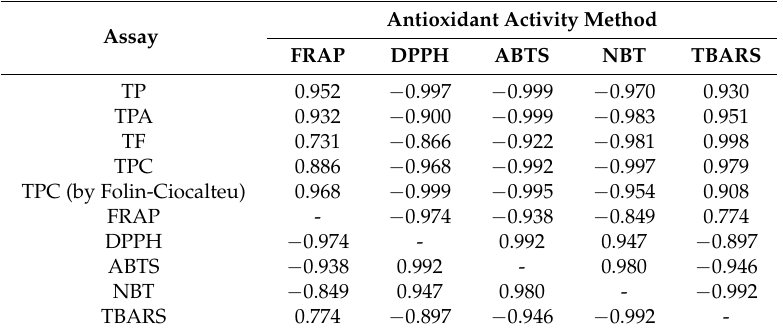
Table 3. Correlation coefficients ( r ) between antioxidant activity values and phenolic contents. Antioxidant Activity Method Assay FRAP DPPH ABTS NBT TBARS TP 0.952 − 0.997 − 0.999 − 0.970 0.930 TPA 0.932 − 0.900 − 0.999 − 0.983 0.951 TF 0.731 − 0.866 − 0.922 − 0.981 0.998 TPC 0.886 − 0.968 − 0.992 − 0.997 0.979 TPC (by Folin-Ciocalteu) 0.968 − 0.999 0.908 FRAP - − 0.974 − 0.938 − 0.849 0.774 DPPH − 0.974 - 0.992 0.947 ABTS − 0.938 0.992 - 0.980 NBT − 0.849 0.947 TBARS